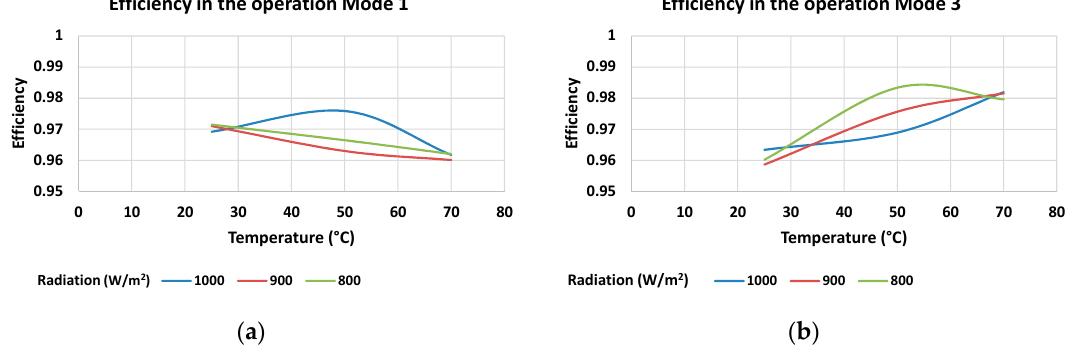
Figure 11. Multifunctional microinverter efficiency during: ( a ) Operation mode 1; ( b ) Operation mode 3.